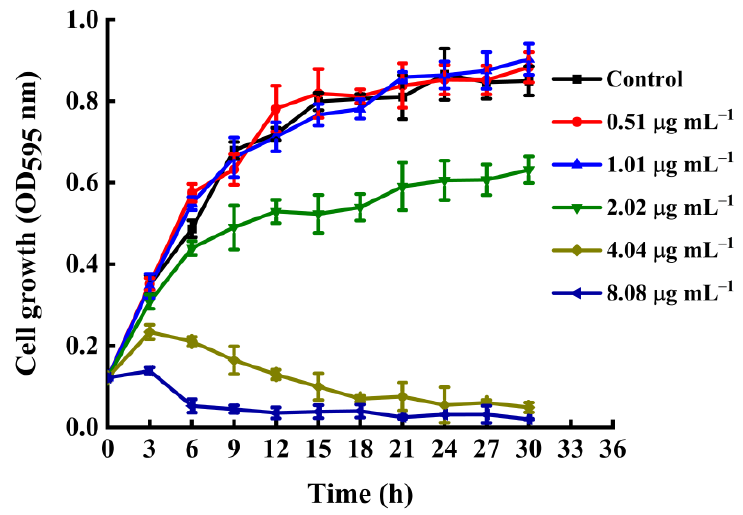
Figure 3. Growth curves of Xoo cells treated with compound C 4 at various dosages (0.51, 1.01, 2.02, 4.04, 8.08 µ g mL − 1 ) in nutrient broth medium.